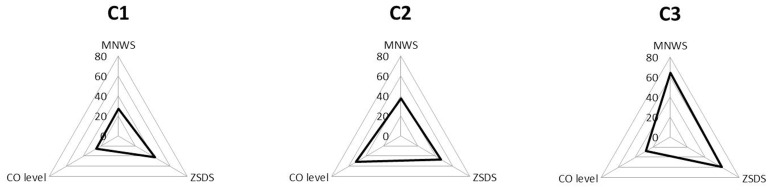
Two-step cluster analysis of three phenotypic variables resulted in three significantly different clusters.Mean scores are represented as percentages of possible maximum points for each measurements. MNWS, Minnesota Nicotine Withdrawal Scale; ZSDS, Zung Self-Rating Depression Scale.